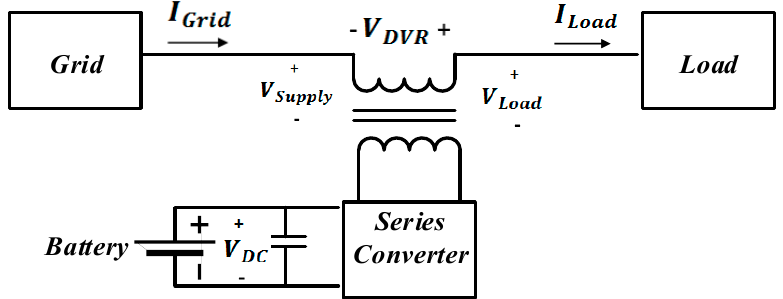
Figure 2. DVR with optimized constant DC-link voltage topology.